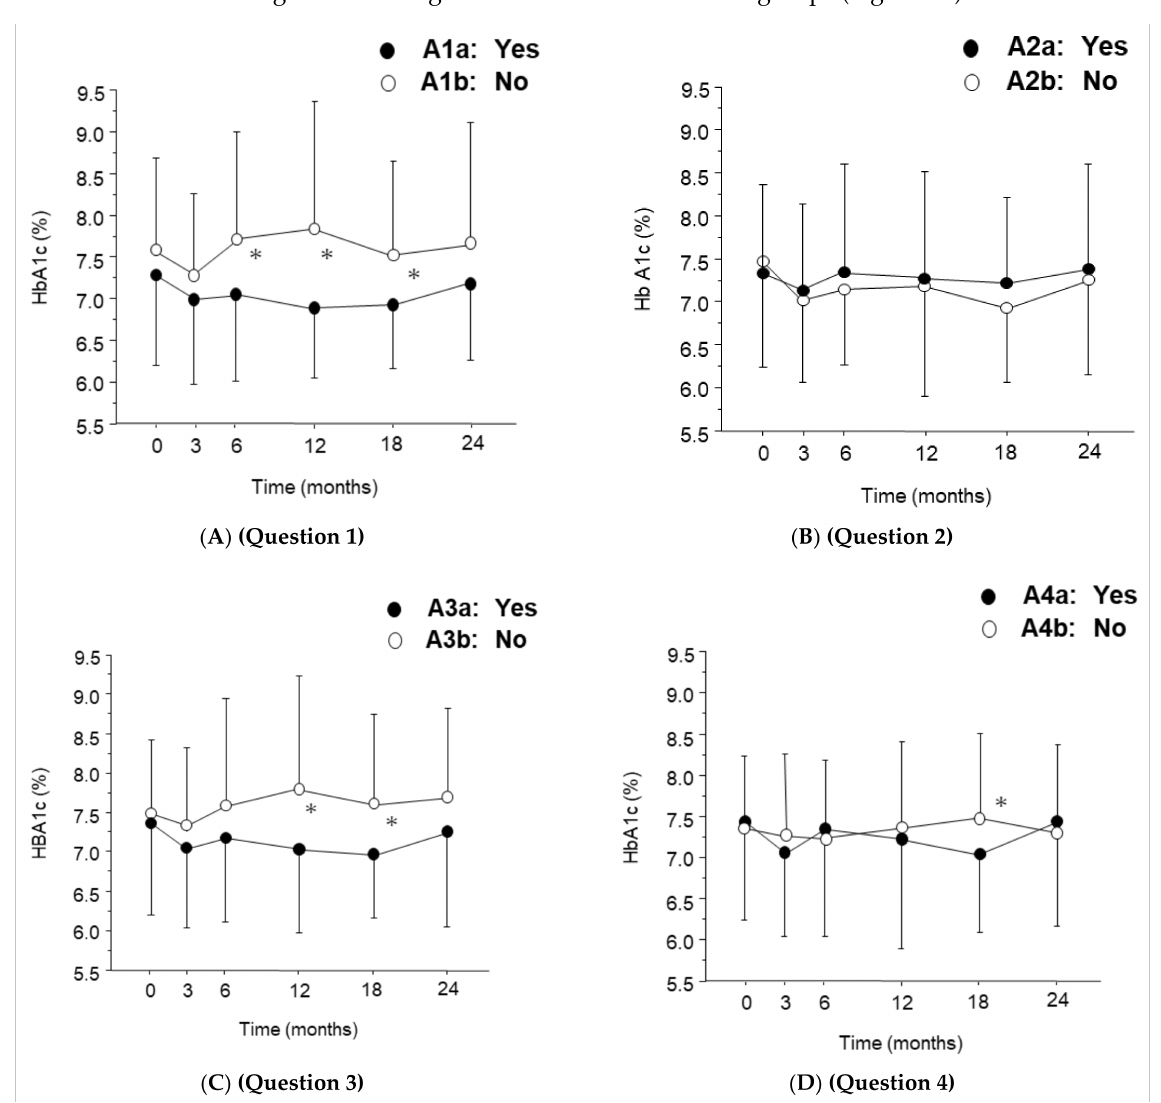
Figure 4. Temporal profile of hemoglobin A1c (HbA1c) in the groups according to the survey responses after initiation of anti-vascular endothelial growth factor (VEGF) therapy. HbA1c levels were measured in patients who answered yes ( • ), and no ( by mean ± standard deviation (SD). * p < 0.05 (versus group by Mann–Whitney U